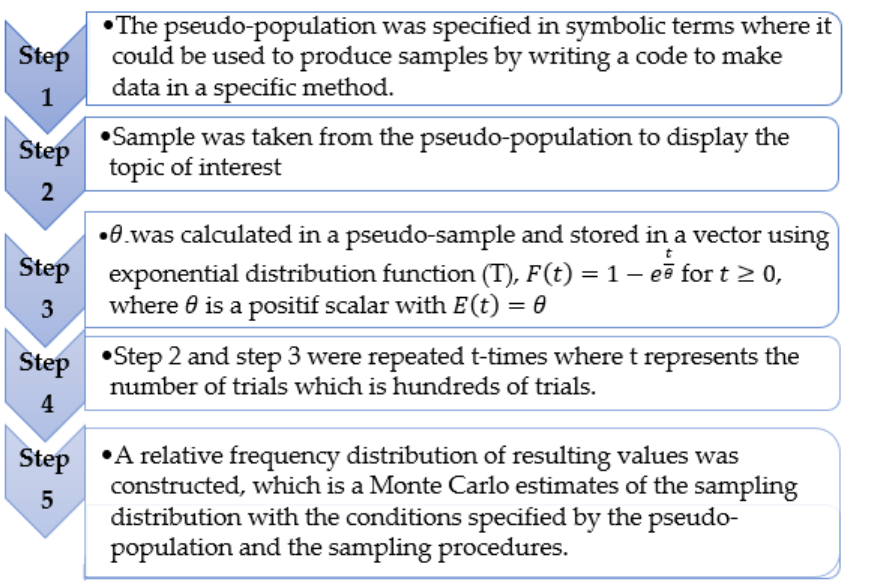
Table 2. Summary statistics of average daily torrential rainfall amounts (mm) for 48